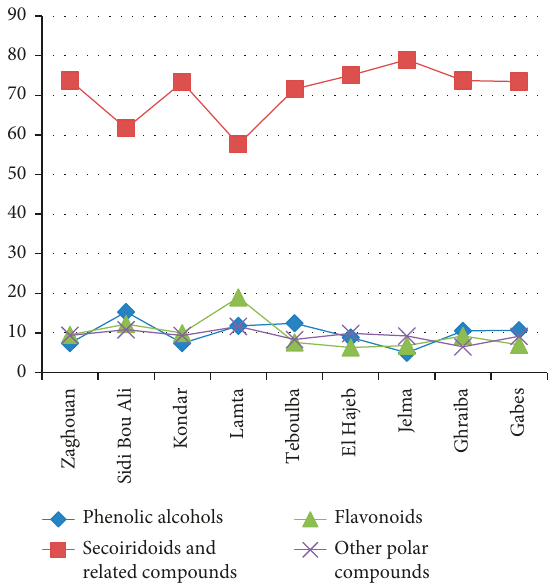
Figure 4: Variation in the distribution of the phenolic compound classes in “Chemlali” olive leaf extracts according to the cultivation regions.